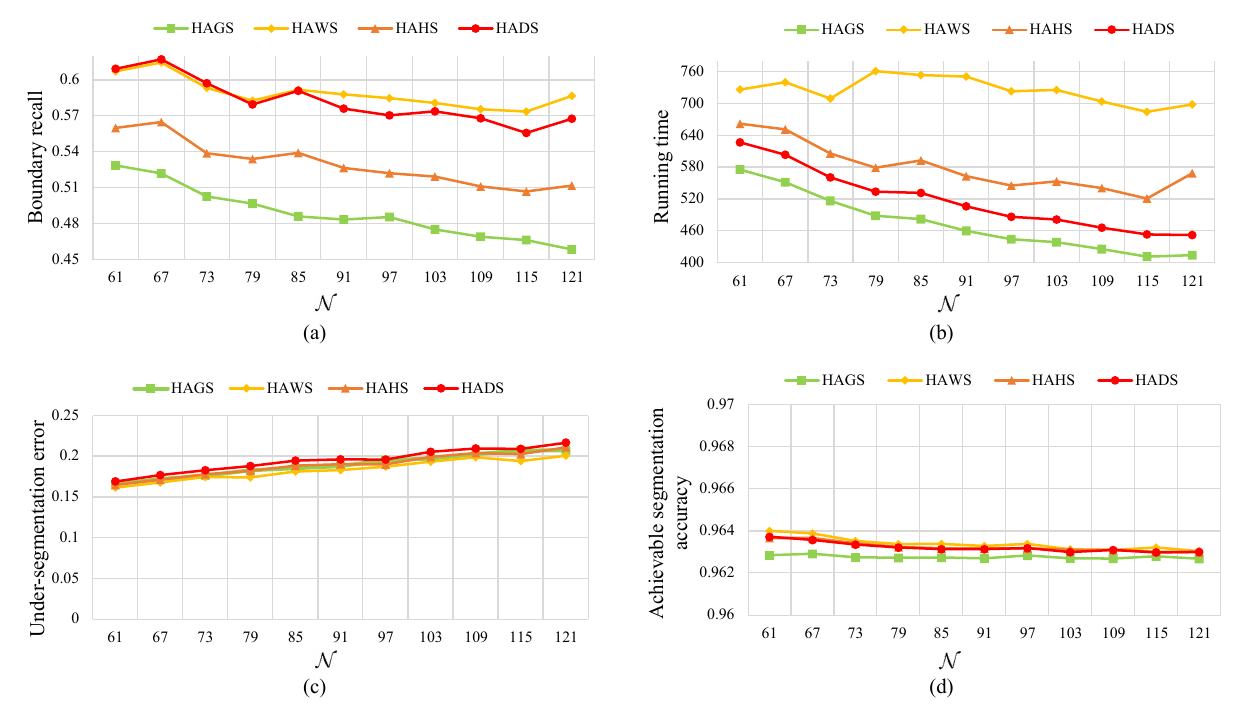
Figure 22. Quantitative evaluation results based on data set 5. ( a ) BR. ( b ) RT(s). ( c ) USE. ( d ) ASA.